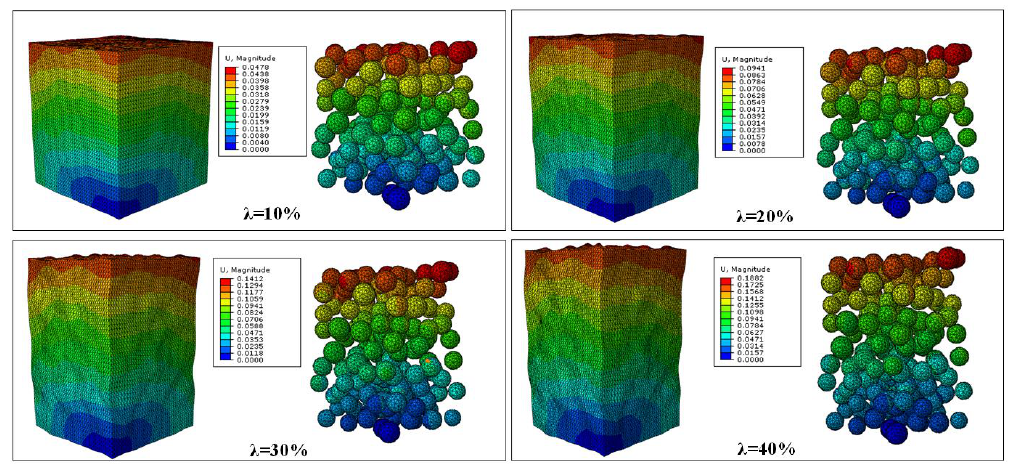
Figure 8. Displacement distribution of the 3D RVE model of EC − 300J CNPs − filled silicone elastomer with 30% volume fraction at different uniaxial elongations λ.